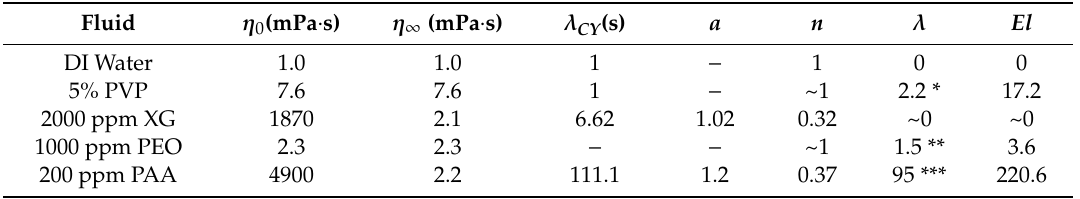
Table 1. Rheological properties of the prepared fluids. Note the elasticity number, El , was calculated at the flow rate of 10 mL /